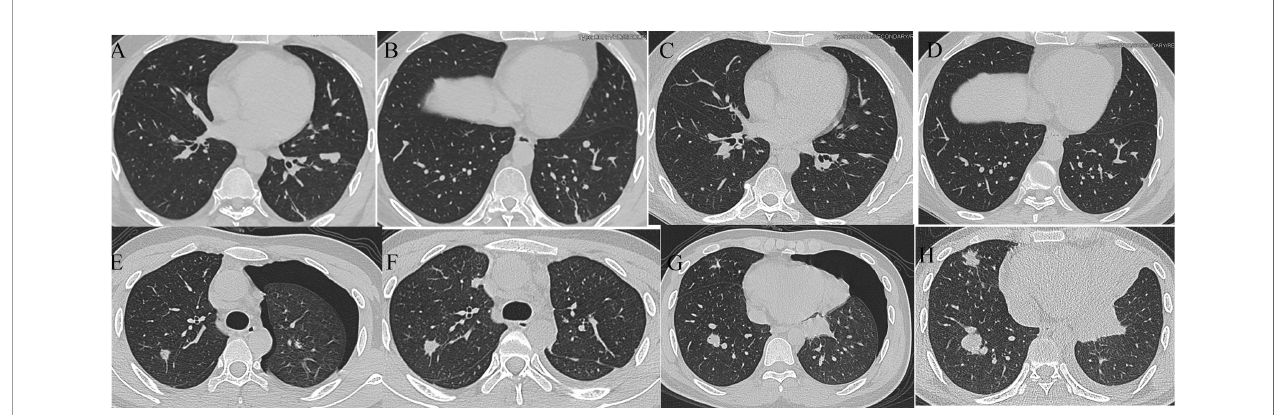
FIGURE 8 | Lung CT results of one PD and one DCR patient. (A, B) Lung CT results of a DCR patient before immunotherapy; (C, D) Lung CT results of a DCR patient after immunotherapy; (E, F) Lung CT results of a PD patient before immunotherapy; (G, H) Lung CT results of a PD patient